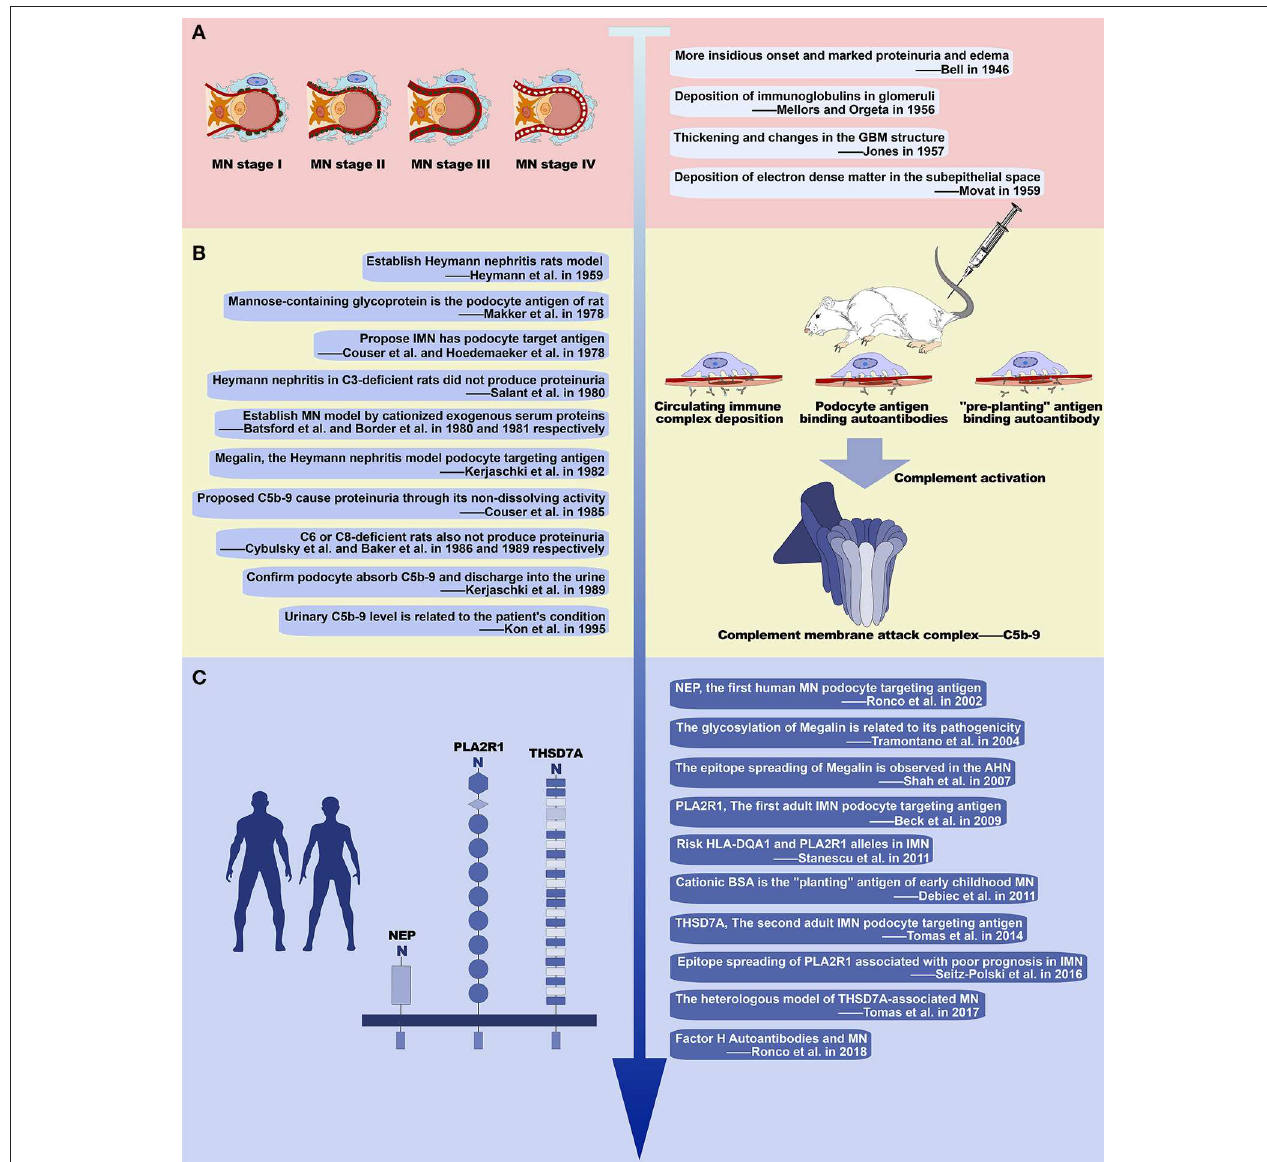
FIGURE 1 | History of the study of membranous nephropathy. (A) Basic pathological features of MN. Illustration of the progression of glomerular lesions in MN (left) with four early studies describing its basic pathological features (right). (B) Studies of experimental MN and important results. Ten seminal studies of experimental MN (left) and the major discoveries relating to development of MN, including immune complex deposition and complement activation (right). (C) Recent advances in our understanding of MN. Three major podocyte antigens found in human MN (left), and other major work on MN since 2000 (right).